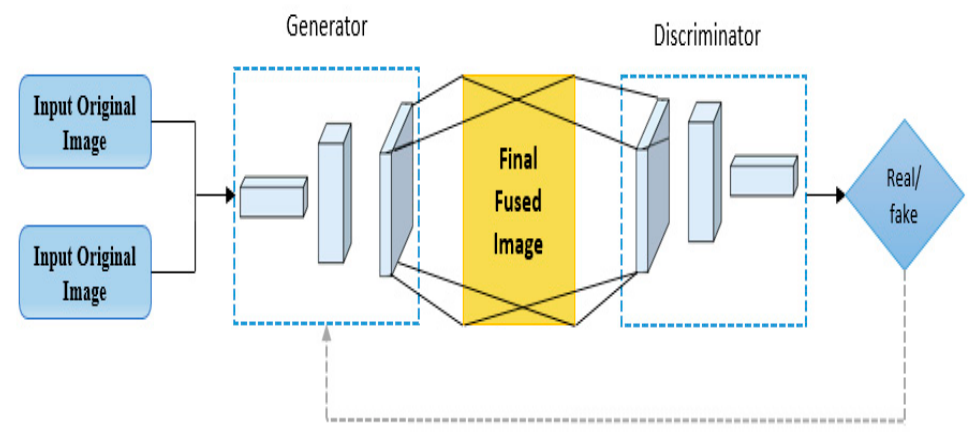
Figure 5. GAN fusion process.